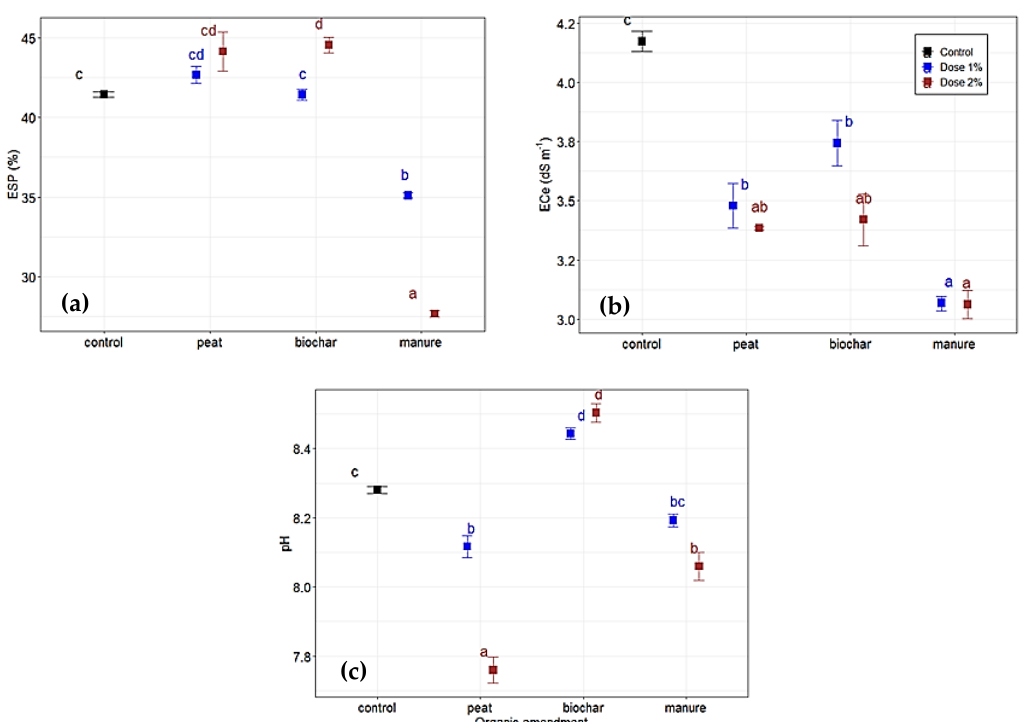
Figure 1. Soil ESP ( a ), EC e ( b ) and pH ( c ), for the interactions between organic amendments and doses. Means sharing a letter are not significantly different according to pairwise comparisons of LSM with Tukey adjustment ( p < 0.05). The bars indicate the standard error.